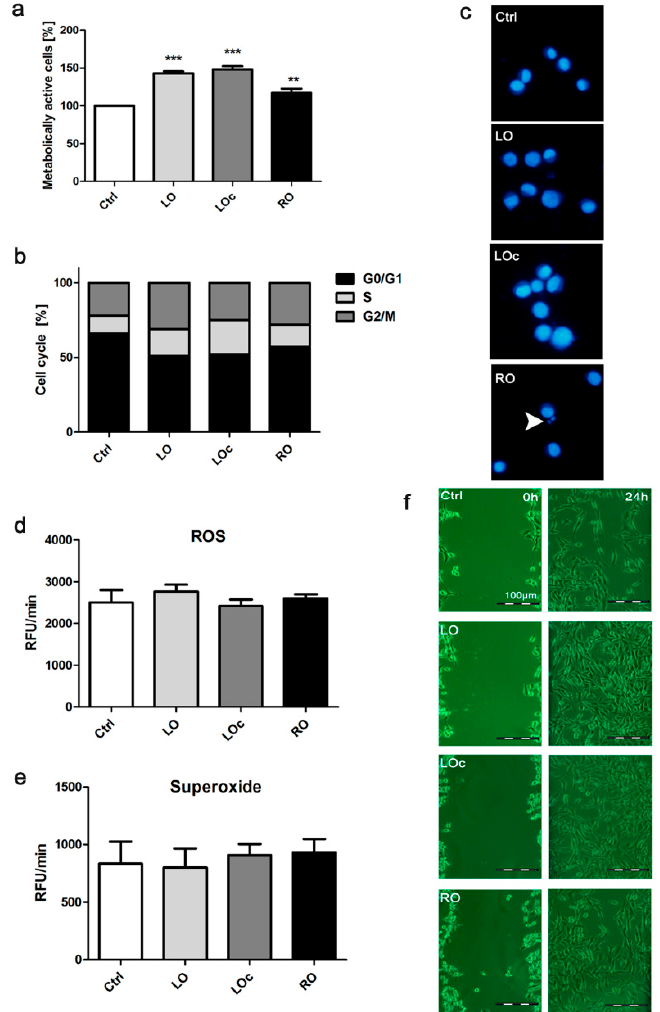
Figure 2. Oil-mediated effects on NIH3T3 cells. Fibroblasts were treated with 0.1% oils for 24 h. ( a ) Metabolic activity was assayed using MTT test; ( b ) DNA content-based cell cycle analysis; ( c ) Micronuclei formation. DNA was visualized using Hoechst 33342 staining (blue). Arrowhead indicates a micronucleus; ( d ) Reactive oxygen species (ROS) production. ( e ) Superoxide production; ( f ) Scratch wound healing assay. Cell migration was evaluated under an inverted microscope. Bars indicate SD, n = 3, ** p < 0.01, *** p < 0.001 compared to untreated control (ANOVA and Dunnett’s